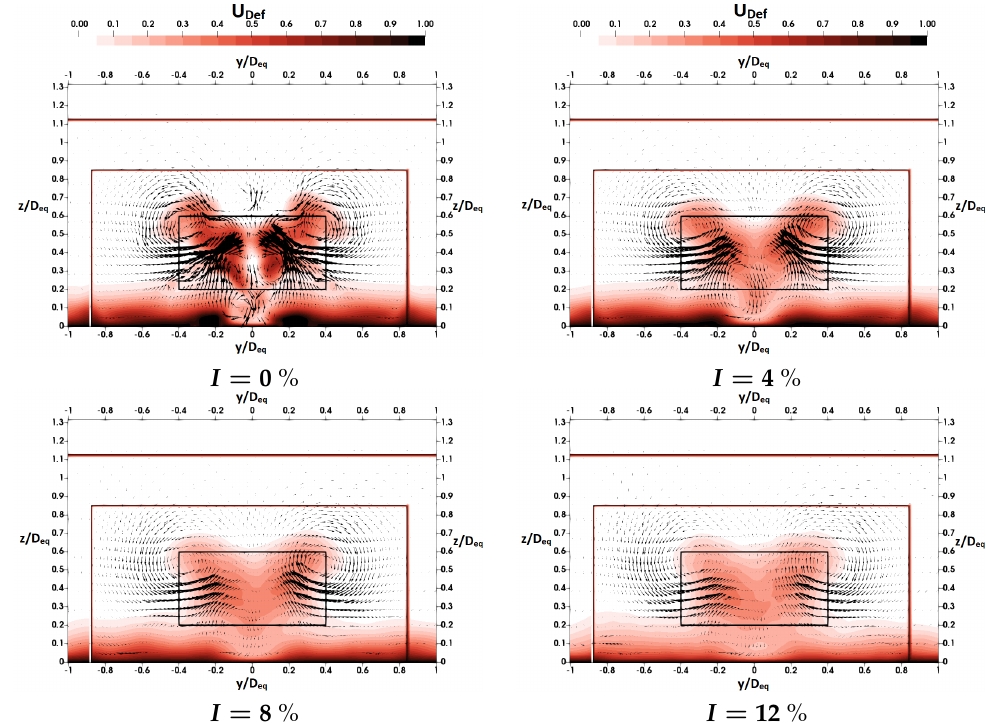
Figure 20. Contour of axial velocity deficit, 1.2 D eq downstream of the turbine. Velocity vectors are projected onto the plane. Turbine footprint is delimited in black. ALM-LBM simulations with four turbulence rates. U Def = 1 − < U x > / U ref .